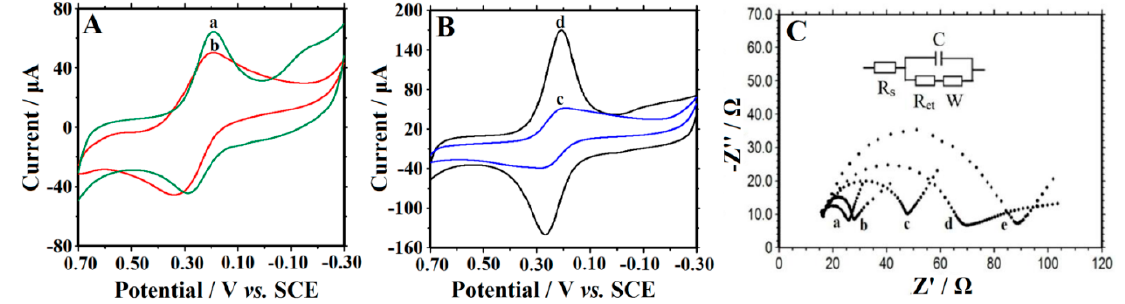
Figure 3. CV of ( A ) CILE (a), CTS/CILE (b); ( B ) CTS/Hb/CILE (c), CTS/CMS-Hb/CILE (d) in a 10.0 mmol·L − 1 [Fe(CN) 6 ] 3 − /4 − and 0.1 mol·L − 1 KCl solution, scan rate:0.1 V·s − 1 ; ( C ) EIS of ( a ) CTS/CMS/CILE;